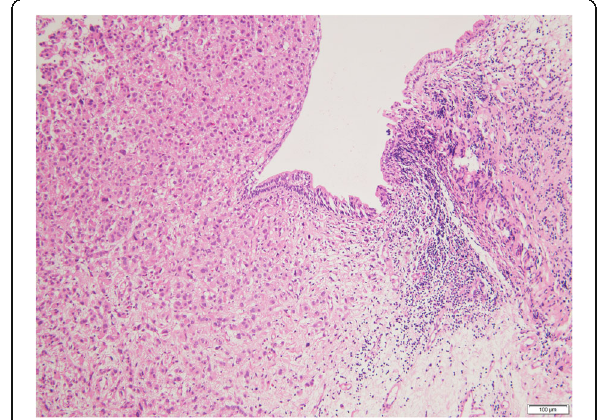
Fig. 2 Histopathology. Eosin-stained cells with a large nucleus are seen proliferating in the lamina propria